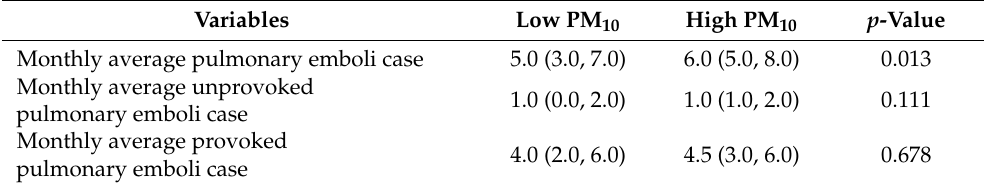
Table 5. Acute pulmonary emboli case during high-PM 10 months ( ≥ 45 µ g/m 3 ) and low-PM 10 months (<45 µ g/m 3 ).